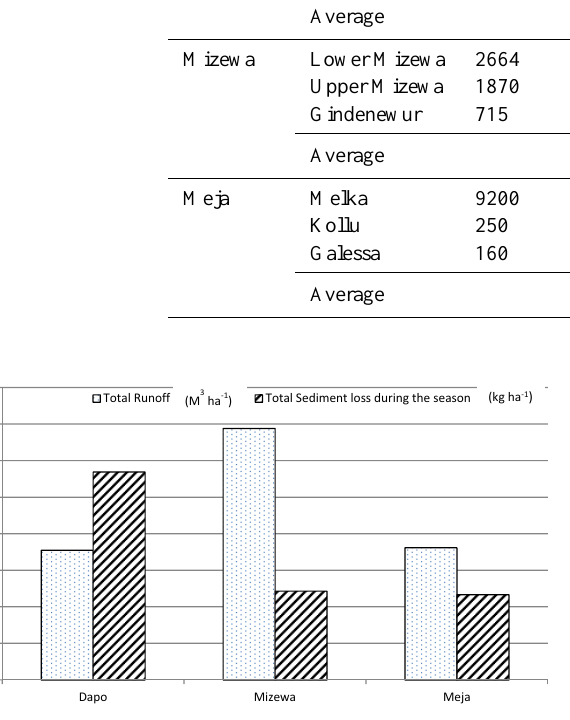
Figure 5. Average runoff in cubic metres per hectare and sediment loss in kilogram per hectare during the measurement period at the study